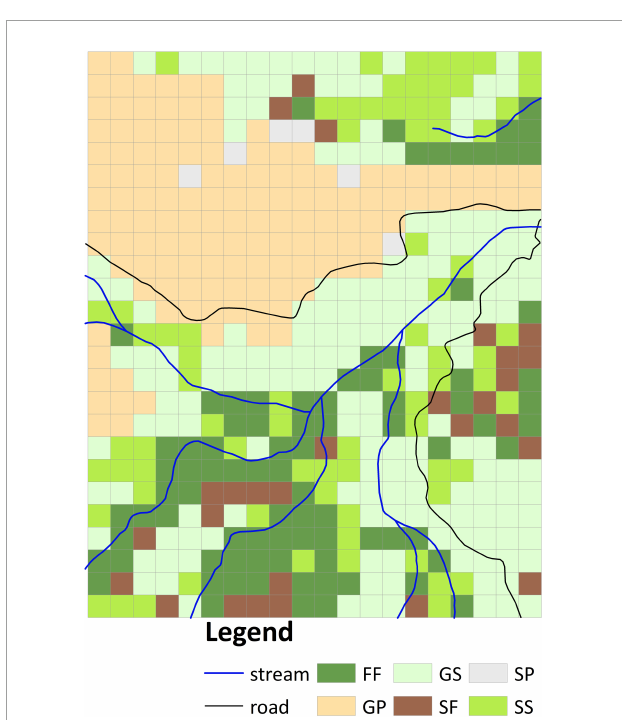
FIGURE2 Classification of vegetation transition types (VTTs) from 1956 to 1963 at 20 m resolution. FF, forest to forest; GP, grassland to plantation; GS, grassland to shrubland; SS, shrubland to shrubland; SF, shrubland to forest; SP, shrubland to